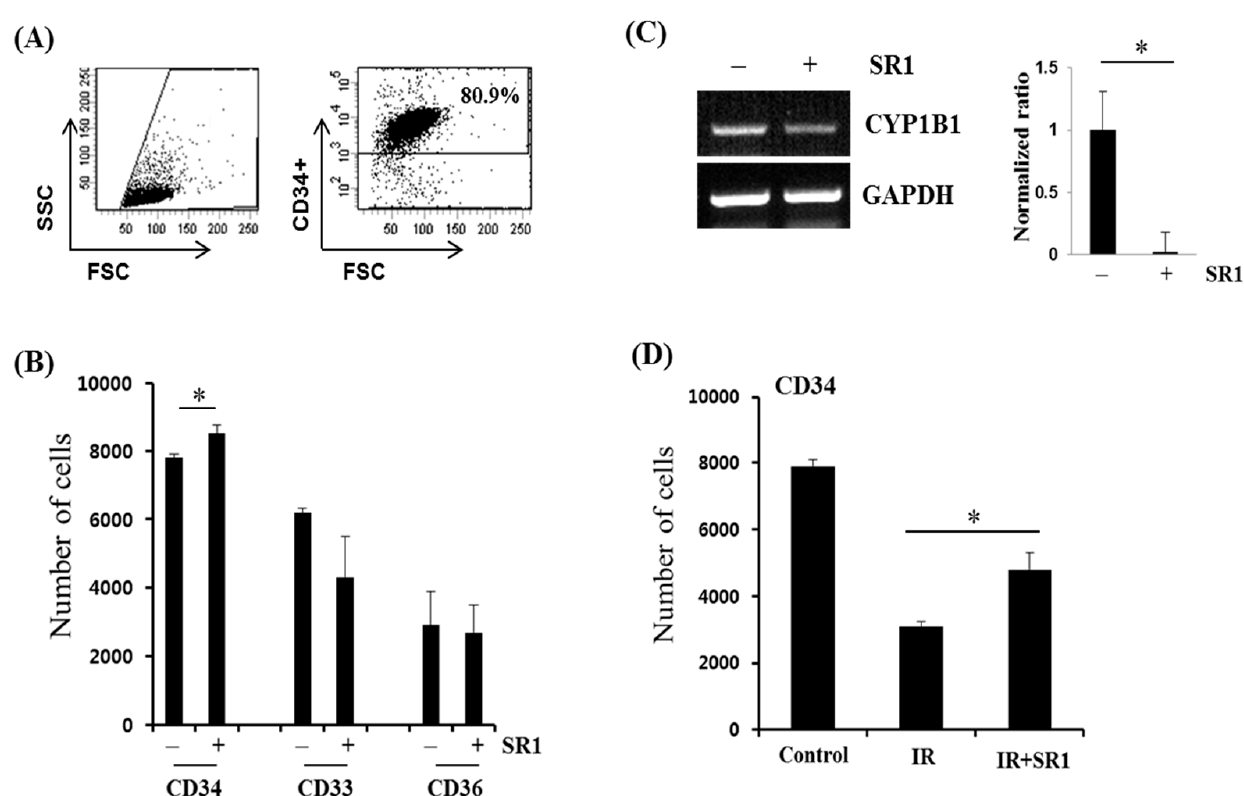
Figure 3. Attenuation of the radiation-induced reduction in HSPC population by Stemneginin 1 (SR1), resulting in HSPC expansion. ( A ) Representative FACS analysis for detecting CD34-positive cells in HSPCs cultured for 5 days. ( B ) Quantification of cells expressing CD34 (HSPCs), CD33 (myeloid), and CD36 (erythrocyte) after SR1 treatment (1 µ M) by FACS analysis. A dataset was collected for 10,000 cells. ( C ) RT-PCR analysis of the expression of CYP1B1 (AhR target gene) in HSPCs with or without SR1 treatment. GAPDH was used as an internal control. The data are shown as means ± SDs of triplicate experiments (* p < 0.05, two-tailed Student’s t -test). ( D ) Quantification of cells expressing CD34 in SR1-treated HSPCs on day 3 after radiation (2 Gy) by FACS analysis. A dataset was collected for 10,000 cells.